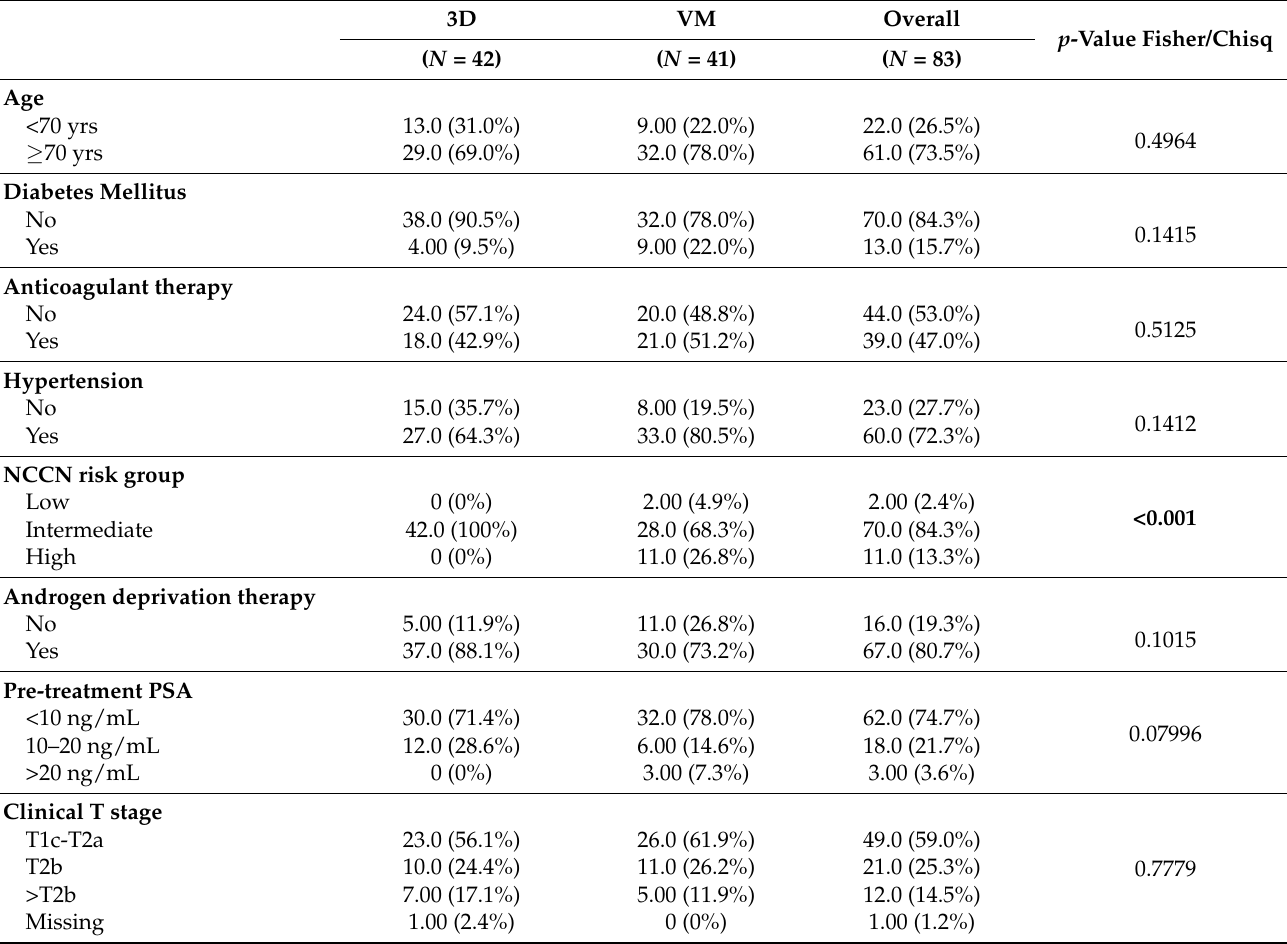
Table 1. Patients’ characteristics: IG-3DCRT = image-guided 3D conformal radiation therapy; IG- VMAT = image-guided volumetric modulated arc therapy; PSA = prostate-specific